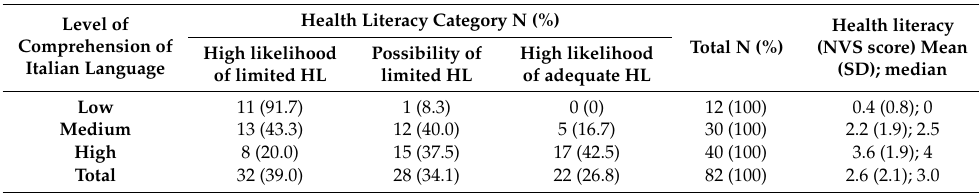
Table 2. The sample interviewed at home: health literacy category by the level of comprehension of the Italian language (for foreigners, N = 82). For the health literacy category, χ 2 test: p < 0.001. For the NVS score, Kruskal–Wallis test: p < 0.001.